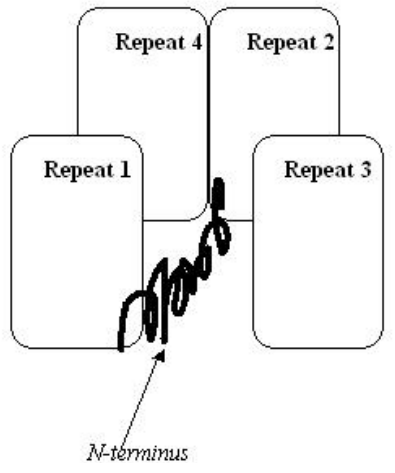
FIGURE 1. A schematic representation of annexin 1 and its N-terminal domain. The four repeats of annexin 1 are shown in which repeat 1 and 4 and repeat 2 and 3 are paired. The N-terminal domain is attached to repeat